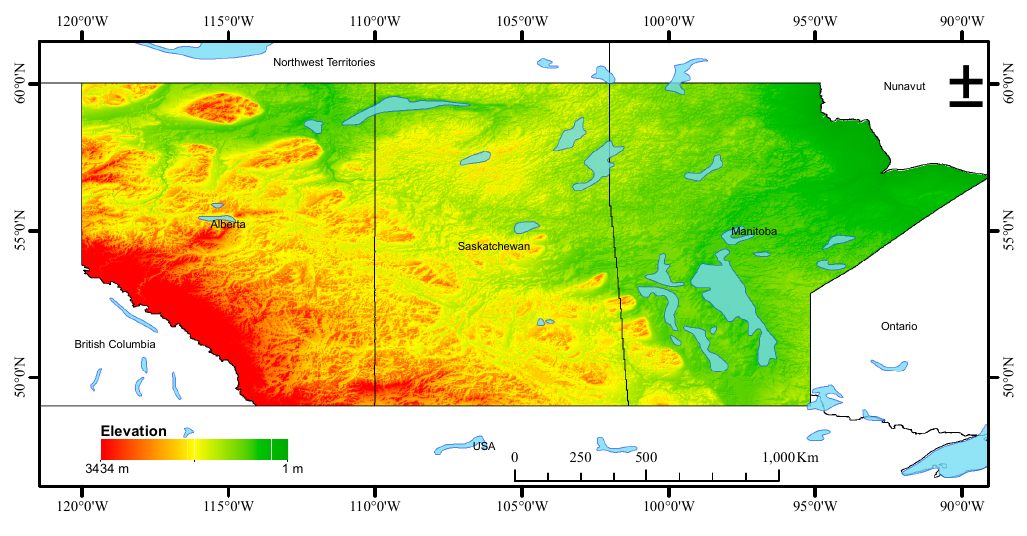
Figure 1. Topography of the study area.